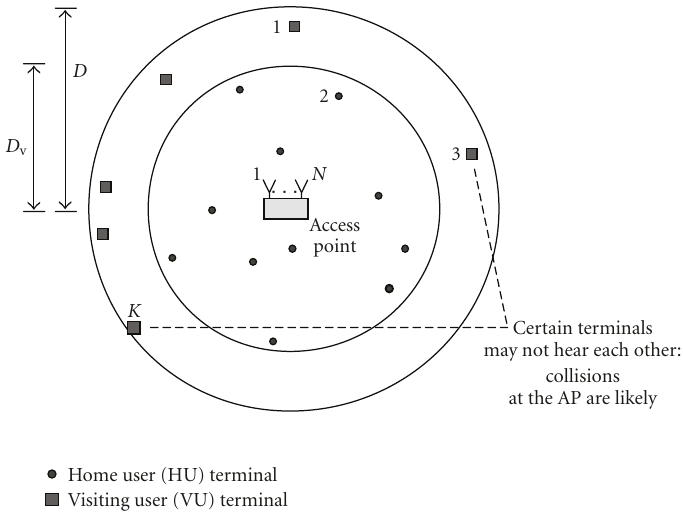
Figure 2: A single-cell OAN scenario with HUs and VUs.